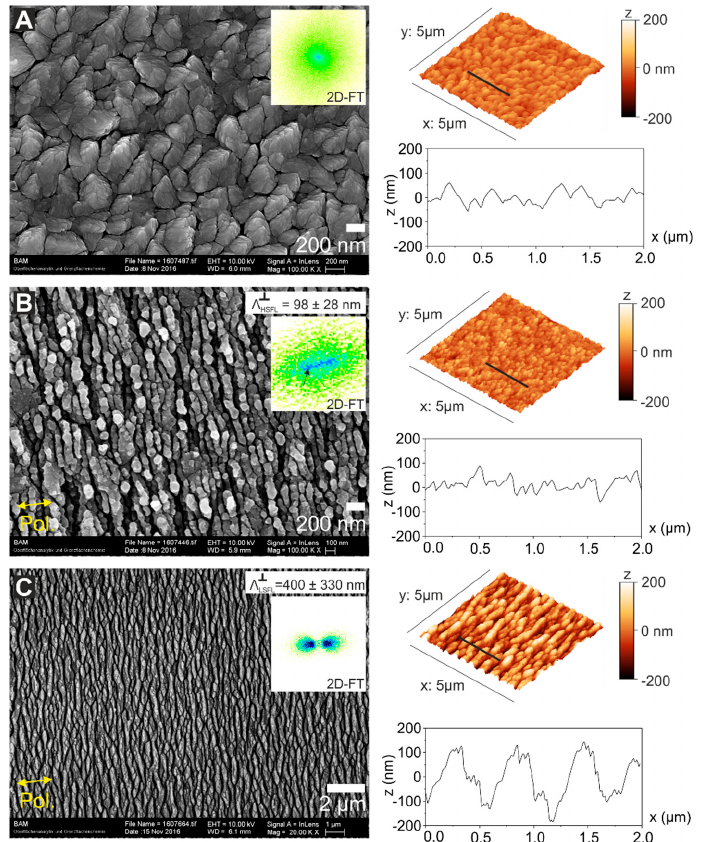
Figure 3. Top-view scanning electron microscopy (SEM) micrographs and 3D reconstructed atomic force microscopy (AFM) data acquired in di ff erent areas of the sample with its corresponding two-dimensional Fourier transform to estimate the structures periodicity ( Λ ). ( A ) Non-irradiated surface showing the randomly oriented CrN grains with no clear periodicity in the Two-dimensional Fourier transform (2D-FT). The AFM data shows a profile taken at the position of the indicated black line, featuring a surface root-mean-squared roughness of R CrN = 25 nm. ( B ) HSFL produced on an irradiated area at φ = 0.15 J / cm 2 , N = 200 and line separation distance ∆ = 50 µ m. The periodicity in this case is 0 e ff _1 D Λ ⊥ = 98 ± 14 nm, the modulation depth is d HSFL ~50 nm and the root-mean-squared-roughness HSFL ⊥ is R HSFL = 30 nm. ( C ) LSFL processed at φ 0 = 0.5 J / cm 2 , N e ff _1 D = 10 and line separation distance ∆ = 50 µ m. The periodicity is Λ ⊥ = 400 ± 330 nm, the modulation depth d HSFL ~200 nm and the LSFL root-mean-squared-roughness is R LSFL = 73 nm. Both structures (Figure 3B,C) were produced with the Ti:Sa system ( λ = 790 nm) and the structures orientation is perpendicular to the laser beam polarization, indicated by yellow double